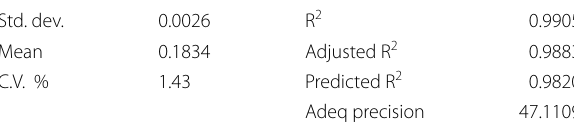
Table 10 Key results from ANOVA (Thermal) Std.